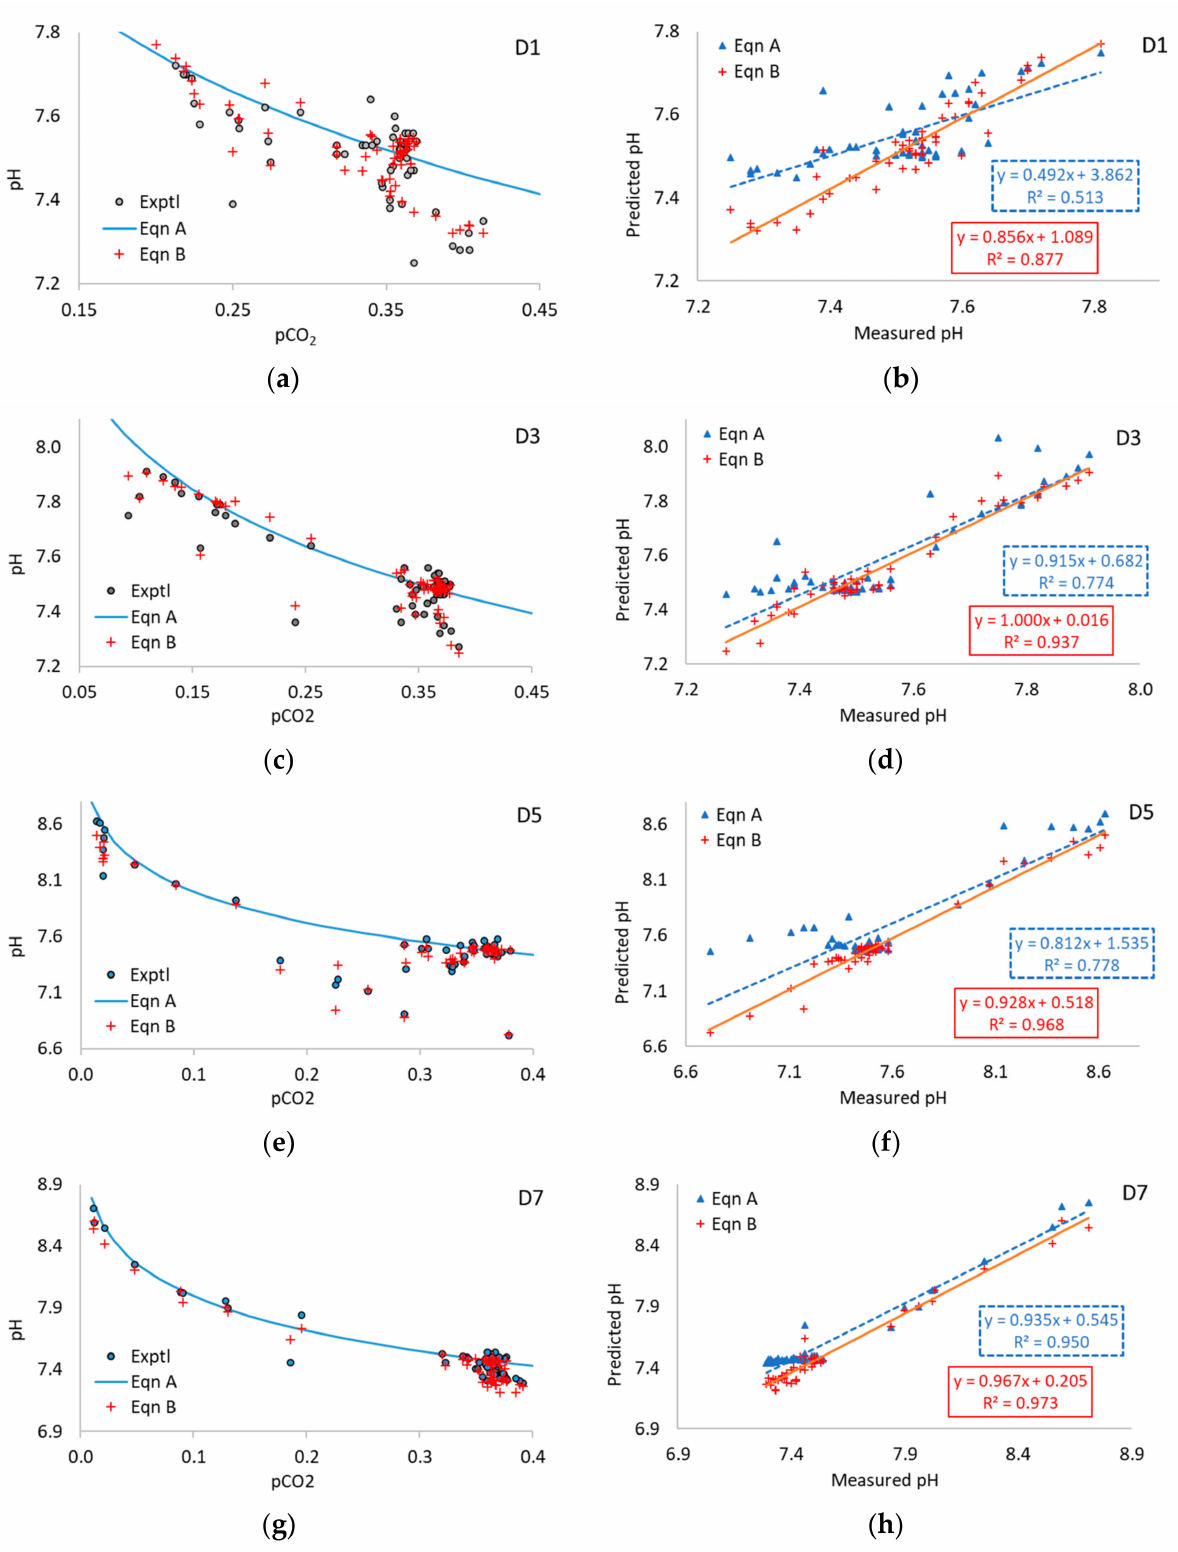
Figure A7. Experimental pCO 2 and pH values and predicted pH from Equations A and B in digesters D1 ( a , b ), D3 ( c , d ), D5 ( e , f ), and D7 ( g , h ) during mesophilic anaerobic digestion of sewage sludge at varying H 2 addition rates. For even-number digesters, see Figure 5 in the main